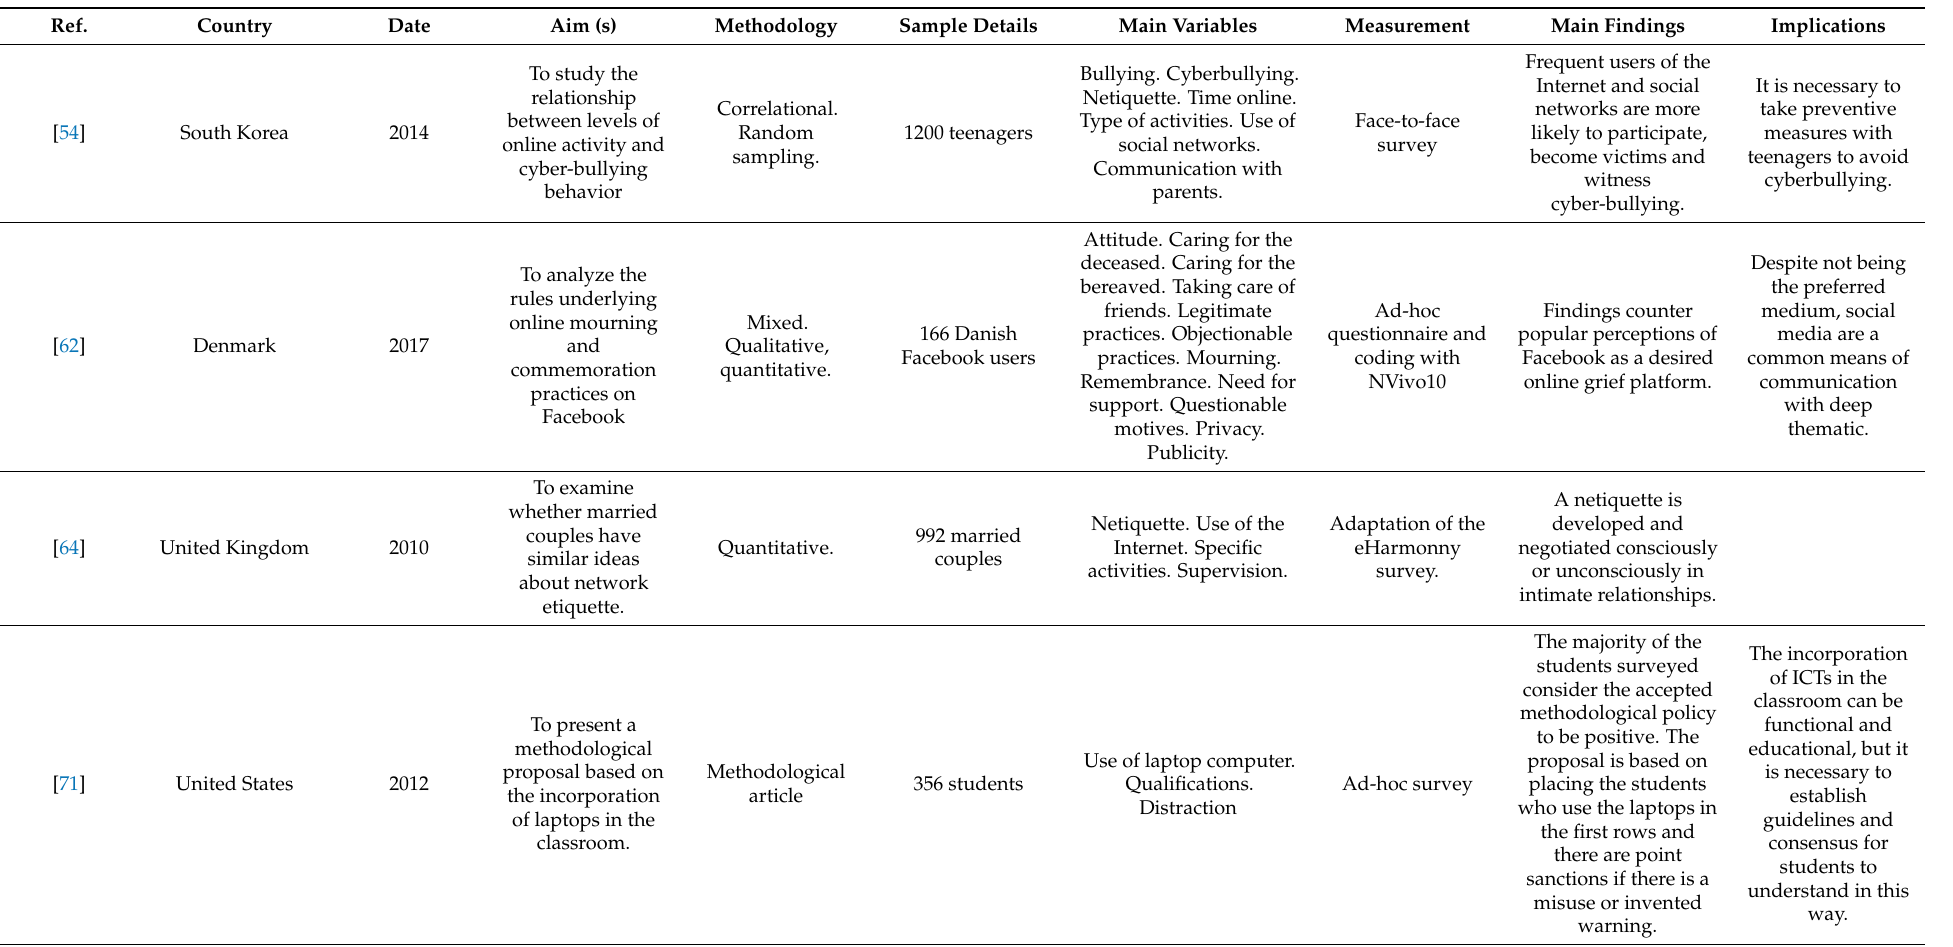
Table A1. Empirical